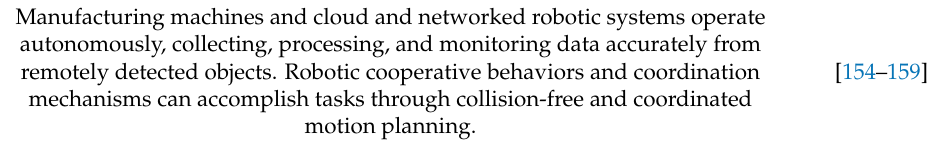
Table 2. Cont. Collaborative IoRT technologies and multiple autonomous mobile robots require predictive maintenance tools throughout edge and cloud computing infrastructures. IoT-based robotic systems and connected devices can perform collaborative tasks by deploying remote sensing environment data in task allocation and collision avoidance. Robotic monitoring capabilities develop on modeling and simulation tools, production operation and machine data, and sensing technology across industrial environments. Mobile navigation technologies, path planning and obstacle avoidance tools, deep neural networks, and machine learning clustering algorithms impact robotic perception and manipulation tasks.